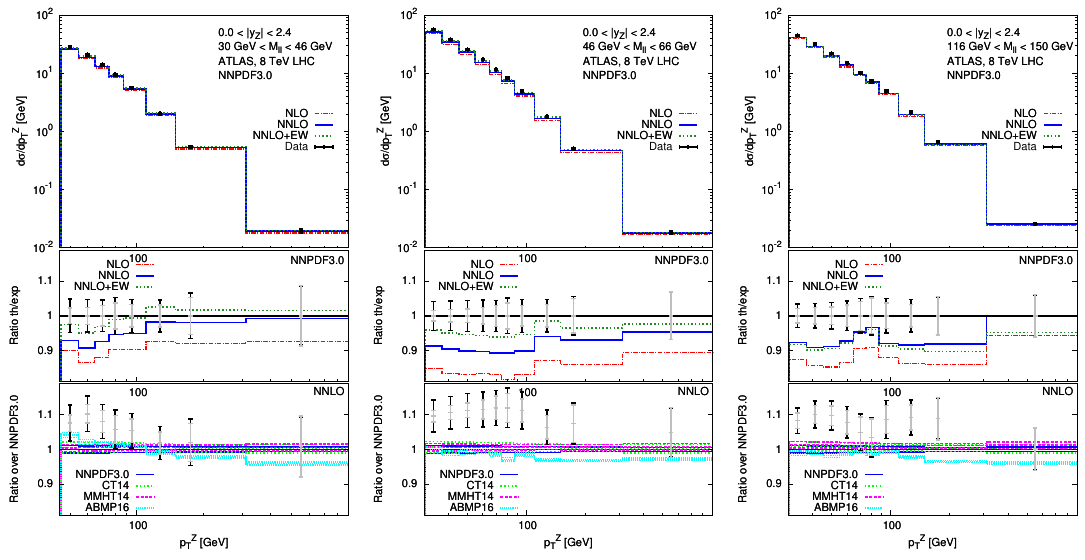
Figure 3 . Same as (cid:12)gure 2 for the two remaining low invariant-mass bins and the high invariant- mass